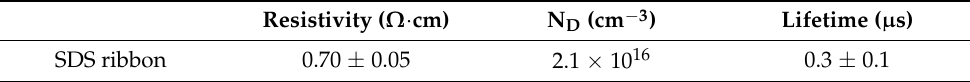
Table 1. Resistivity, dopant concentration, and carrier lifetime of SDS ribbon